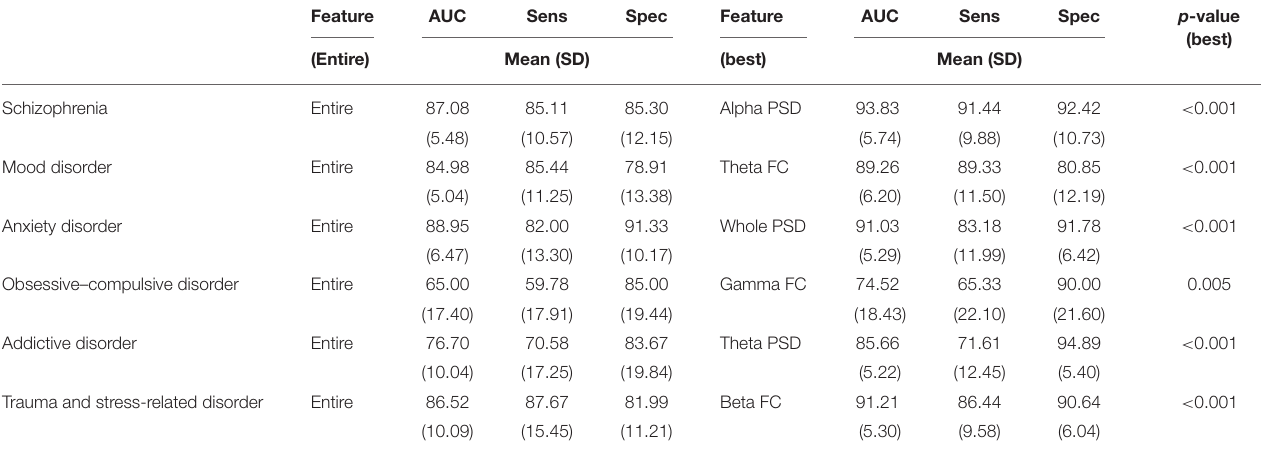
TABLE 2 | Comparison of elastic net models in predicting outcomes in patients with psychiatric disorders distinguished from healthy controls in major category diagnoses. Feature